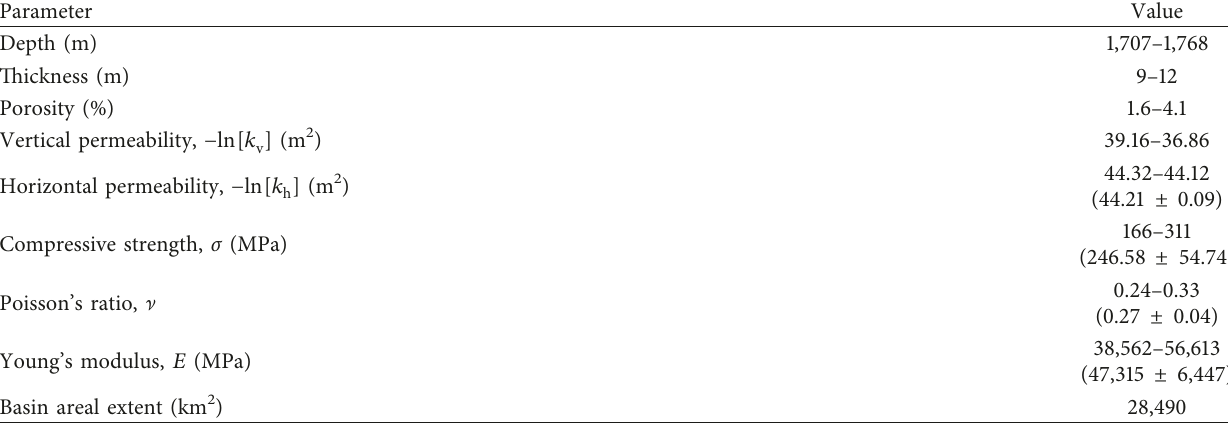
Table 3: Physical data of geological seals considered for saline CO